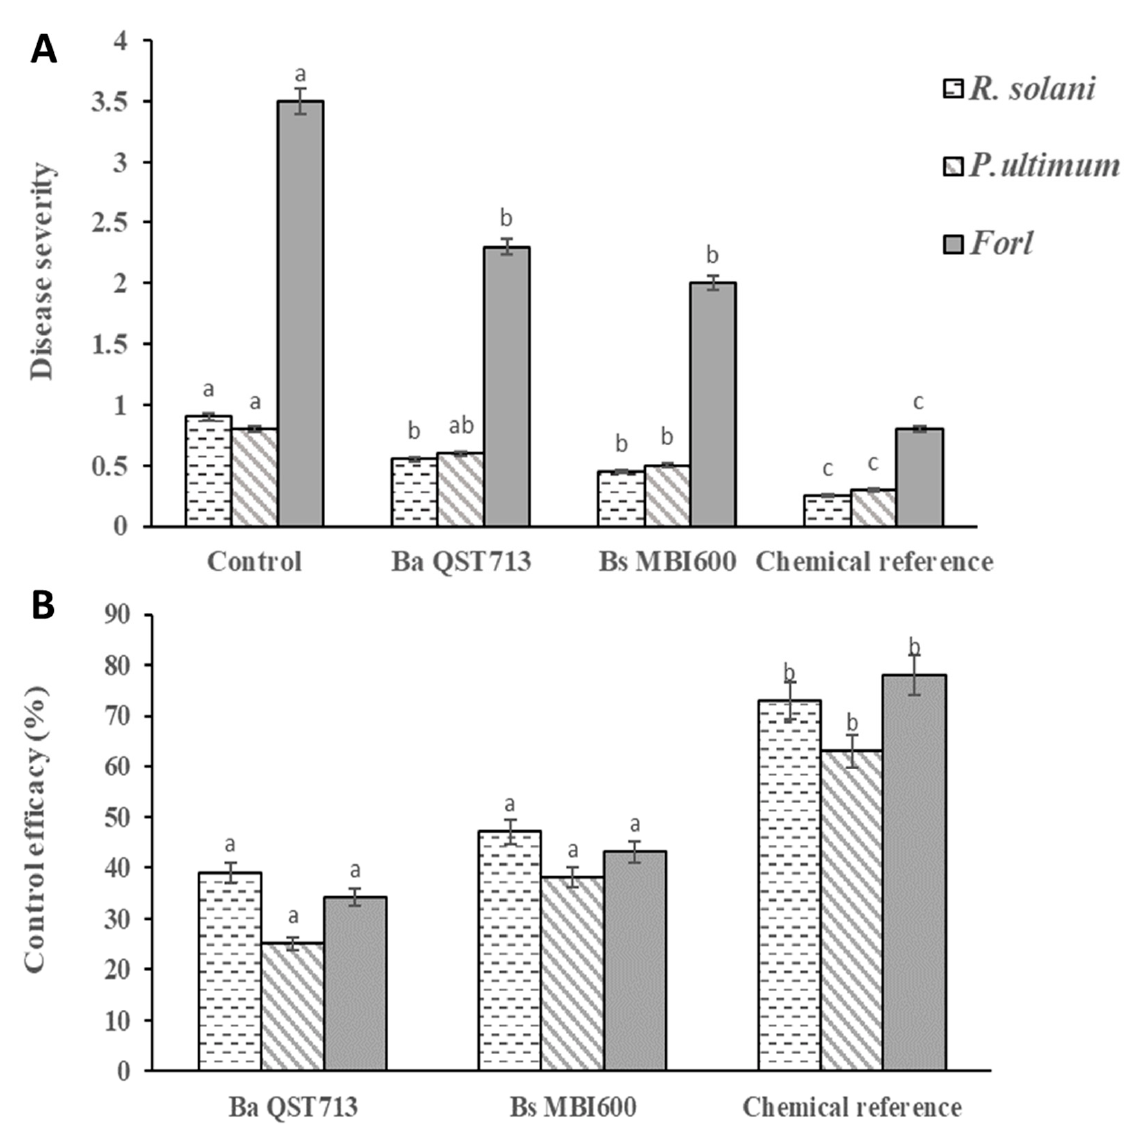
Figure 2. Disease severity ( A ) and control efficacy (%) ( B ) in tomato plants (cv. Belladonna) artificially inoculated with Rhizoctonia solani, Pythium ultimum, or Fusarium oxysporum f.sp. radicis-lycopersici and treated with the biological control agent Bacillus subtilis MBI600 ( Bs MBI600). Bacillus amyloliquefaciens QST713 ( Ba QST713) and 8-hydroxyquinoline or hymexazol were the commercial biological and chemical reference treatments, respectively. Disease severity values for Forl and for R. solani or P.ultimum were measured based on 0–4 and 0–1 disease index scales, respectively. Mean values followed by different letters in the column are significantly different between the applications at p = 0.05, according to Fisher’s LSD test. Bars in the columns indicate the standard error of the mean obtained from two independent replications.